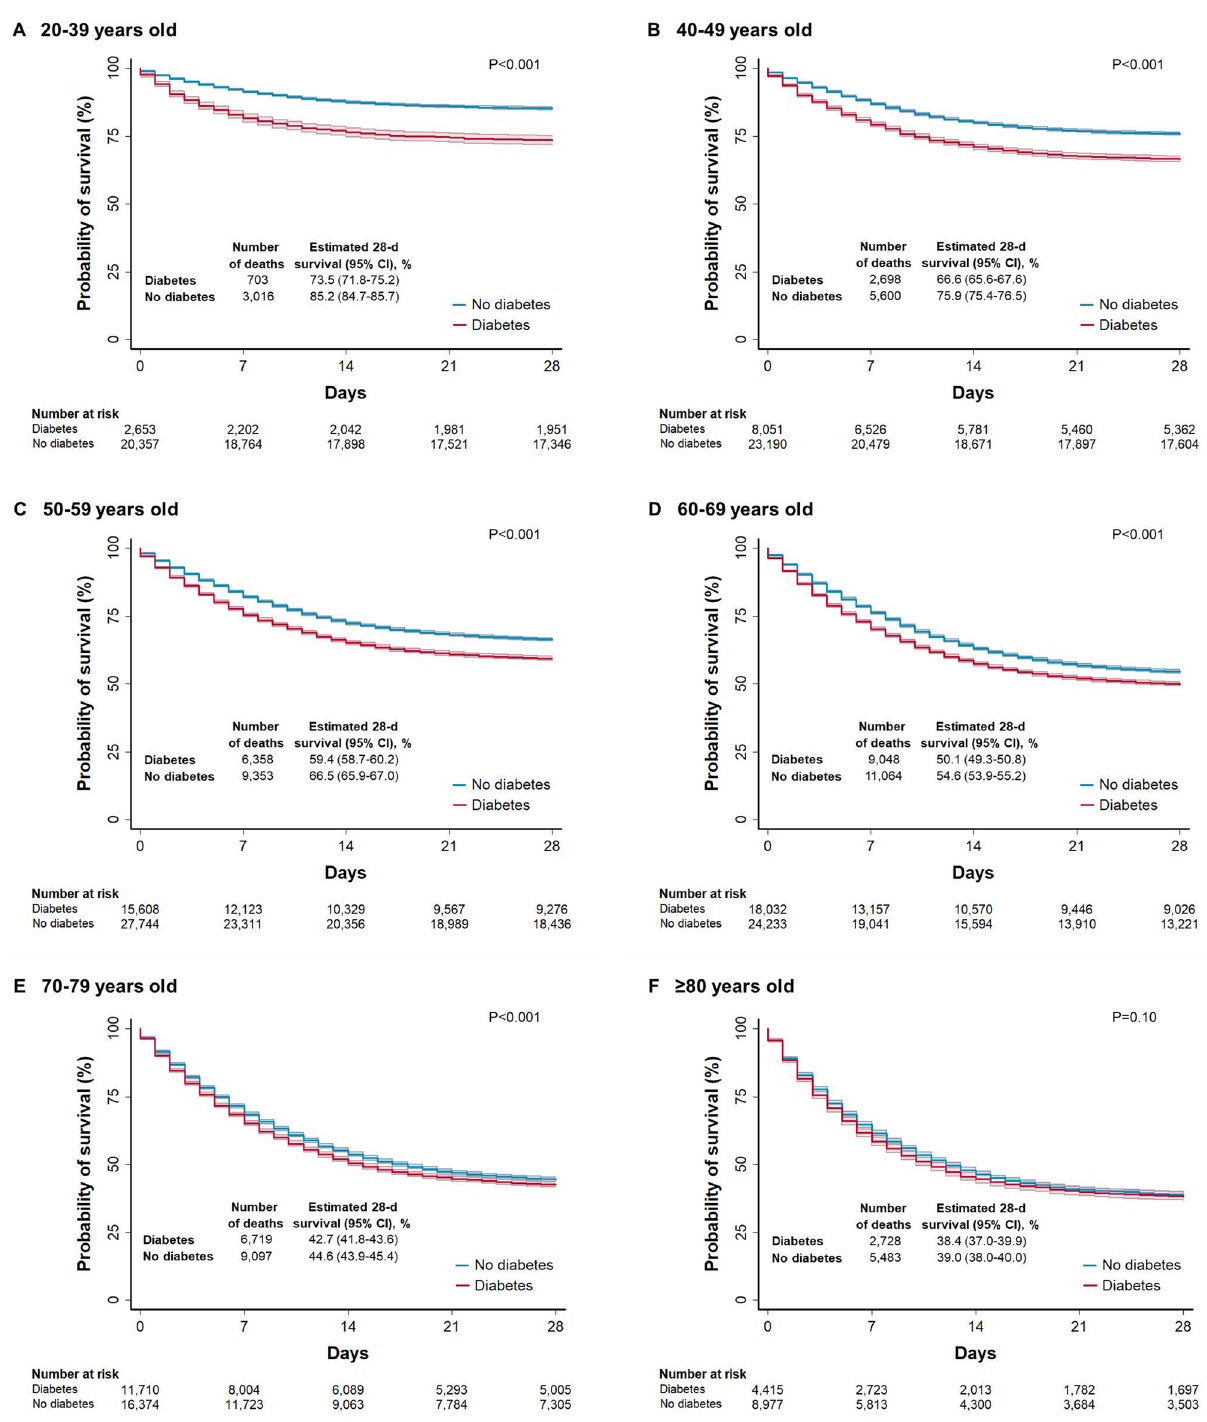
Figure 2. Unadjusted Kaplan–Meier survival curves according to age for inpatients with COVID-19. Panels A to F show the probability of survival stratified according to age groups among adult inpatients with and without diabetes who had COVID-19. Subjects were evaluated and notified from January 1 through October 7, 2020, and followed up for 28 days unless the event (death) occurred first. The solid lines represent survival probabilities and the shaded area represent the 95% confidence intervals